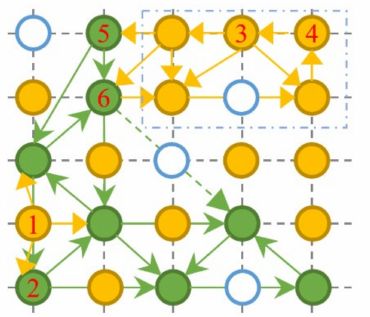
Figure 2. Schematic diagram of the second-level